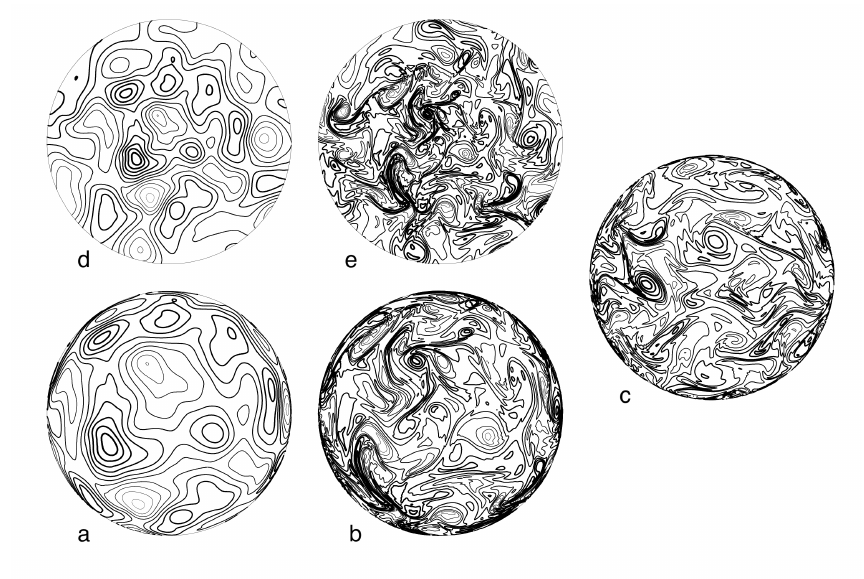
Figure 4. The same as Figure 3 but for the case Ω = 50 of Earth-like rotation. This solution differs from that of Figure 3 in that isolated coherent vortices are less prominent, and that elongated, jet-like structures are beginning to appear, especially near the equator in ( c ), where the β -effect is